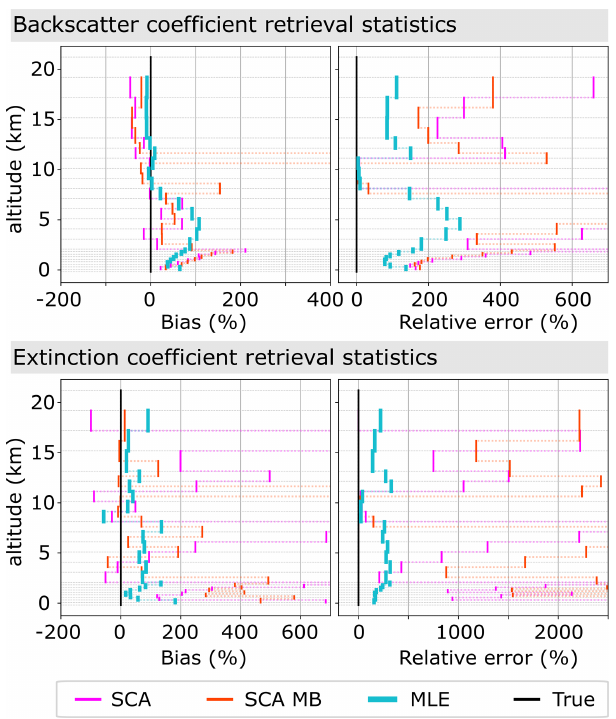
Figure 5. Simulation case II: as Fig. 3 for case